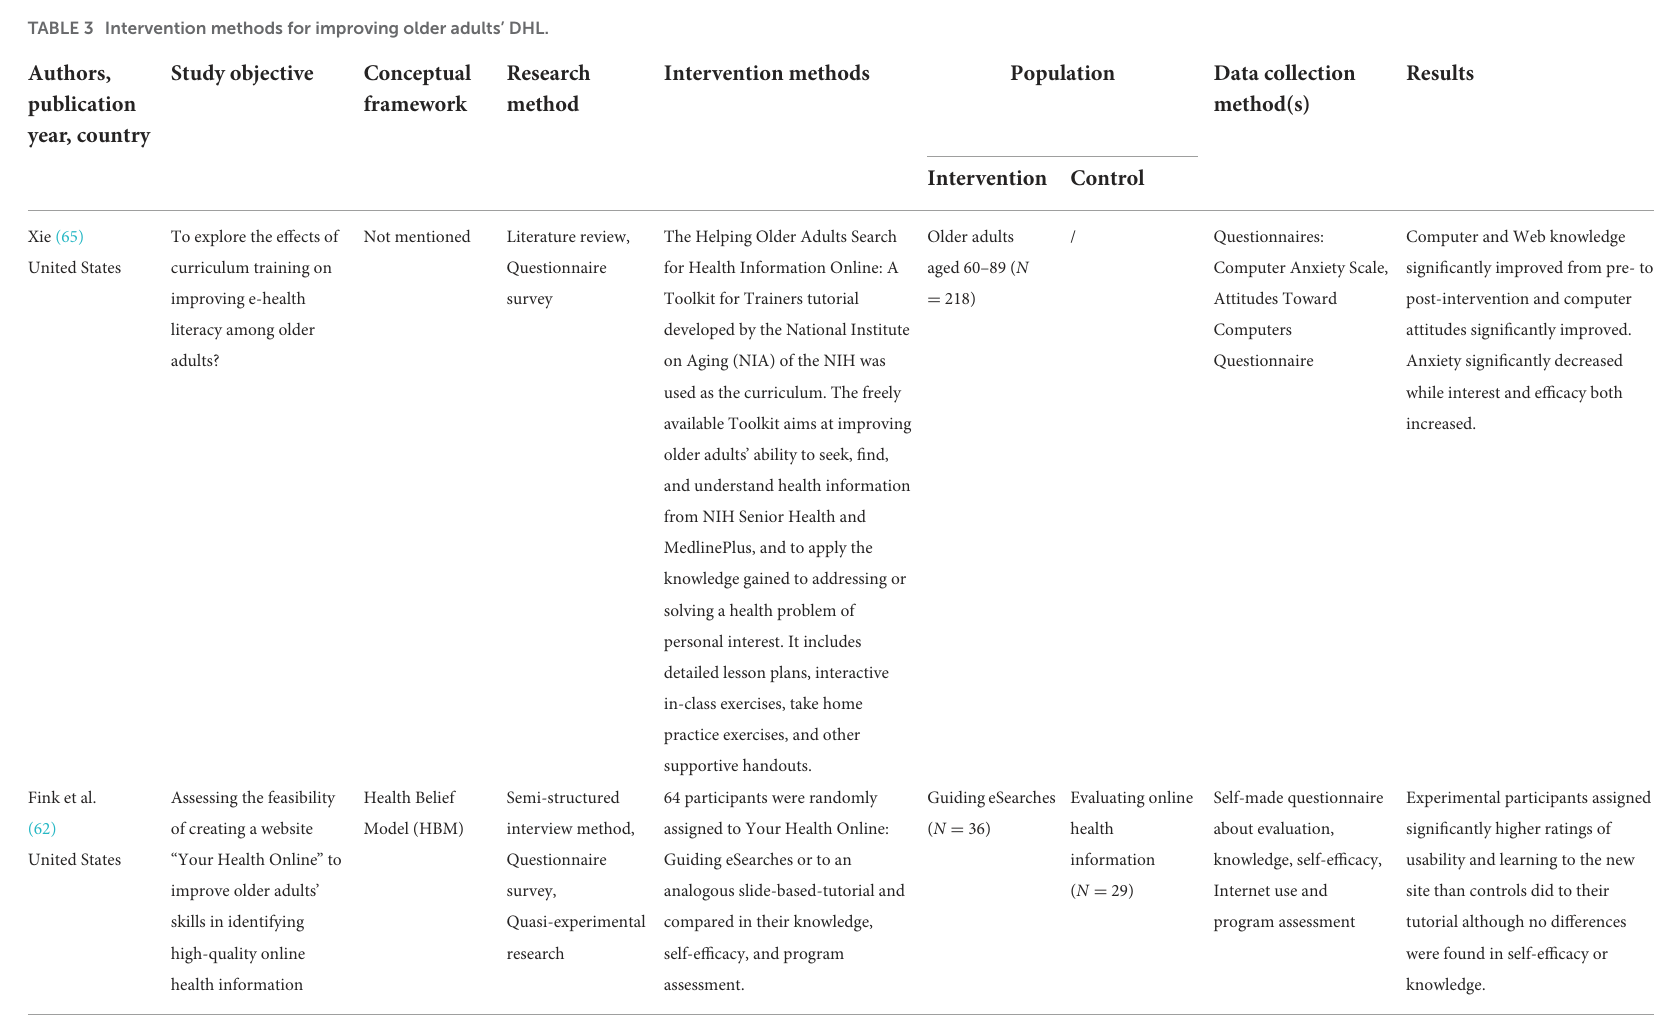
TABLE 3 Intervention methods for improving older adults’